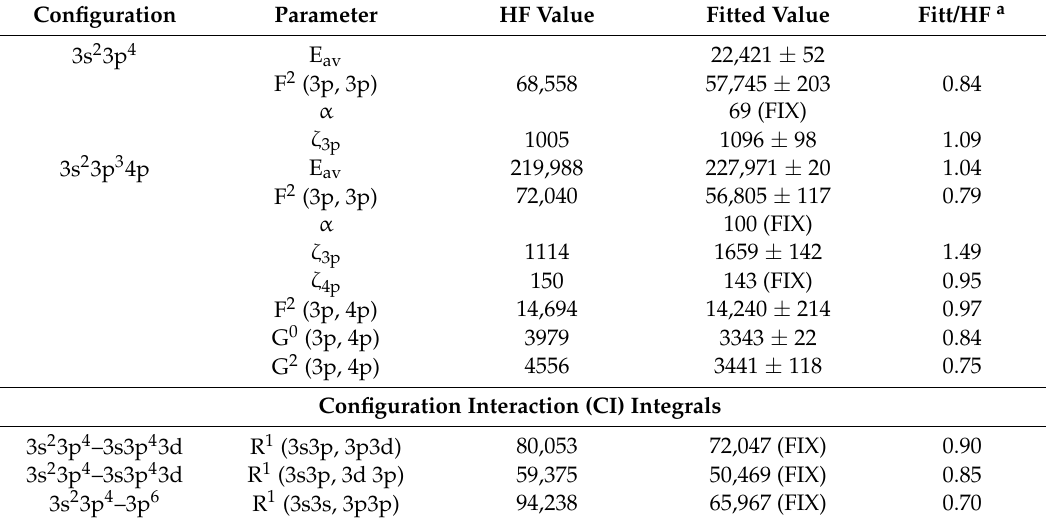
a Parameters omitted from this table: direct and exchange integrals and spin-orbit ζ parameters set to 85% and 95% of their HF values, respectively; CI integrals were set to 85% of their HF values. The standard deviation for the energy adjustment was 101 cm − 1